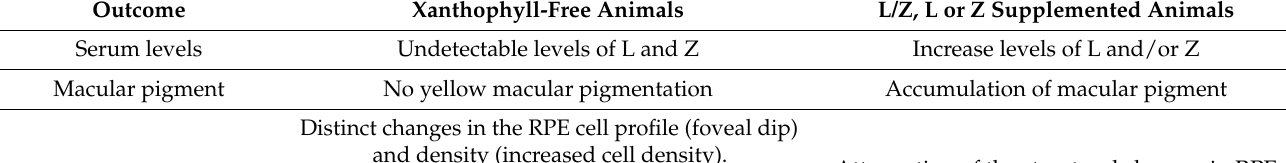
Decreased foveal vulnerability to acute blue-light